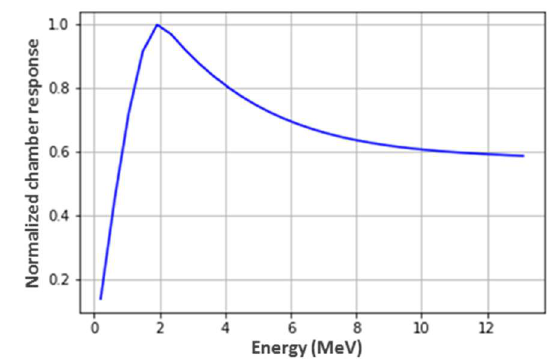
Fig. 3. Response curve (cid:1844)(cid:3435)(cid:1831) (cid:3037) (cid:3439) of the ionization chamber as a function of energy. However, we have checked that the convergence of the method depends only slightly on the response used, but the response must be consistent with the transmission measurements. The convergence is the same within 10% even we use a monotonic increasing or flat